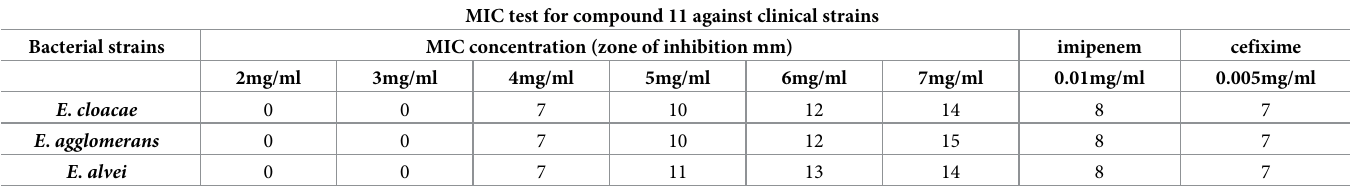
Table 3. Minimum inhibitory concentration of compound 11 against clinical bacterial isolates.